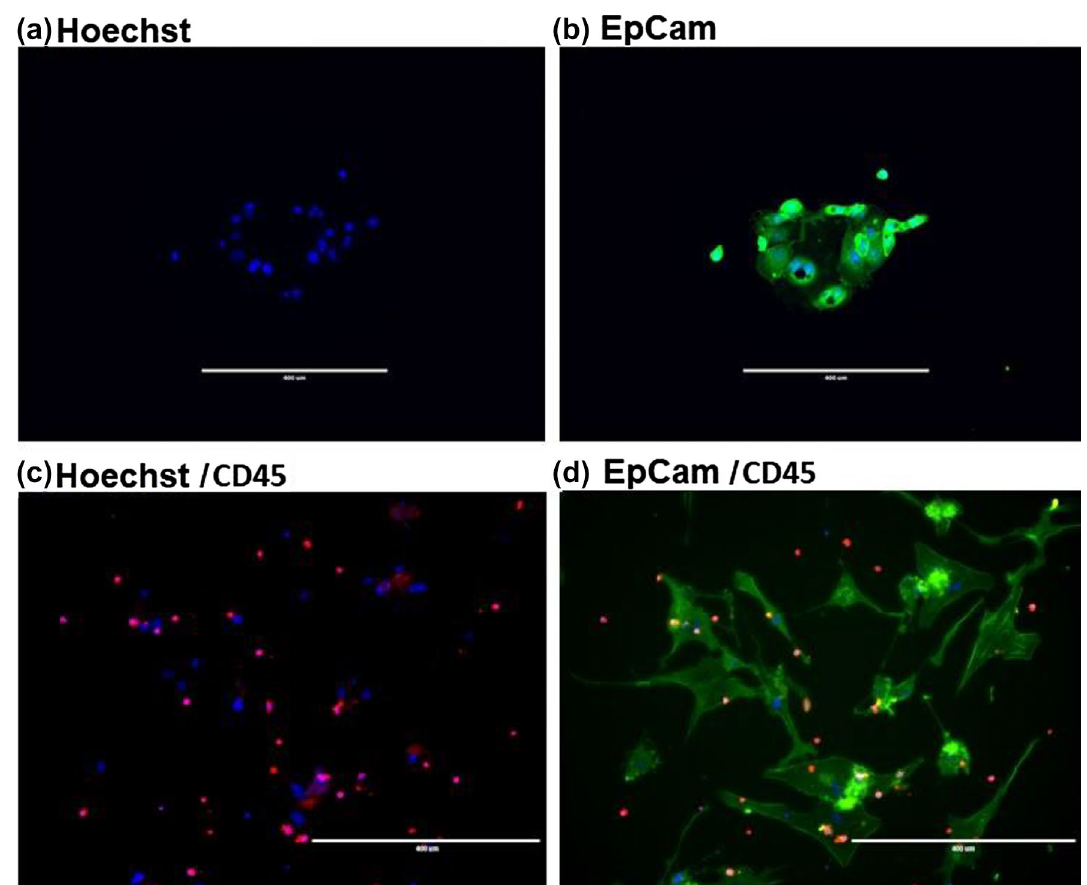
Figure 8. Iimmunofluorescent staining of isolated CTCs captured and isolated from an ovarian cancer patient using the ScreenCell device, ( a , b ). CTCs were immunofluorescently stained for ( a ) Hoechst, ( b ) EpCam (green). Ovarian cancer cells isolated from ascites of ovarian cancer patients, ( c , d ) . These cells were co-cultured with PBMCs. Following that, cells were fixed in 3% PFA, gently washed with PBS, and probed with anti-EpCam and anti-CD45 antibodies. Our results showed that only cancer cells were EpCam positive (green), while PBMCs were only positively stained with PE-conjugated anti-CD45 antibody (red), and cells were also stained with Hoechst 33342, (blue) for nuclear visualisation. Images were taken with an inverted microscope The expression of HIF-1α was increased when primary ovarian cancer cells were cultured in media sup- plemented with 20% (v/v) of FCS and exposed to CoCl 2 at concentrations ranging from 100 to 150 µM. A significant increase in the level of HIF-1α protein at 100 and 150 µM suggested that CoCl 2 mimics hypoxia in primary ovarian cancer cells by activating HIF-1α expression and/or blocking the degradation of HIF-1α, which normally occurs in other cells in the presence of sufficient oxygen or normoxia 45 . During hypoxia, HIF-1α protein accumulates and binds to hypoxia response elements contained within the promoter region of many genes, such as those that regulate metabolism, cell survival, and angiogenesis 36,37 . While this cell biology supports the growth of cancer in vivo , the cell viability and proliferation rate of the primary ovarian cancer cells was also enhanced by exposure to CoCl 2 at concentrations of 100–150 µM. Cell cycle analysis showed that the treatment of cells with 200 µM CoCl 2 induced an accumulation of cells in G0/G1, but this effect was not observed at the lower concentrations. Hypoxia can result in the induction of p21 in many cell types, leading to a G1 arrest 50 . Even though a possible interruption in G2/M has been reported in some hypoxia-stimulated cell lines 51 , our results revealed that the proportion of ovarian cancer cells in G2/M phase was reduced following the exposure to 200 µM of CoCl 2 . Consequently, there was a significant reduction in HIF-1α expression and cell numbers for cultures treated with 200 µM of CoCl 2, establishing 100/150 µM CoCl 2 as the optimal concentration to maintain CTC viability and to effect cell growth. PHH3 expression was increased at concentrations of 100–150 µM of CoCl 2, suggesting that the primary ovar- ian cancer cells were able to maintain their metabolic and physiological activity under these hypoxia-mimicking conditions. Histone H3 is a nuclear core histone protein of DNA chromatin, with an important role in chromo- some condensation and cell-cycle progression during mitosis and meiosis, operating by phosphorylation of serine-10 and serine-28 residues 52,53 . In mammalian cells, in the late G2 phase, phosphorylation begins first in pericentromeric heterochromatin and, as mitosis proceeds, this occurs throughout the entire chromosome; which is completed in the late prophase and maintained through metaphase 44 . There was a significant decrease